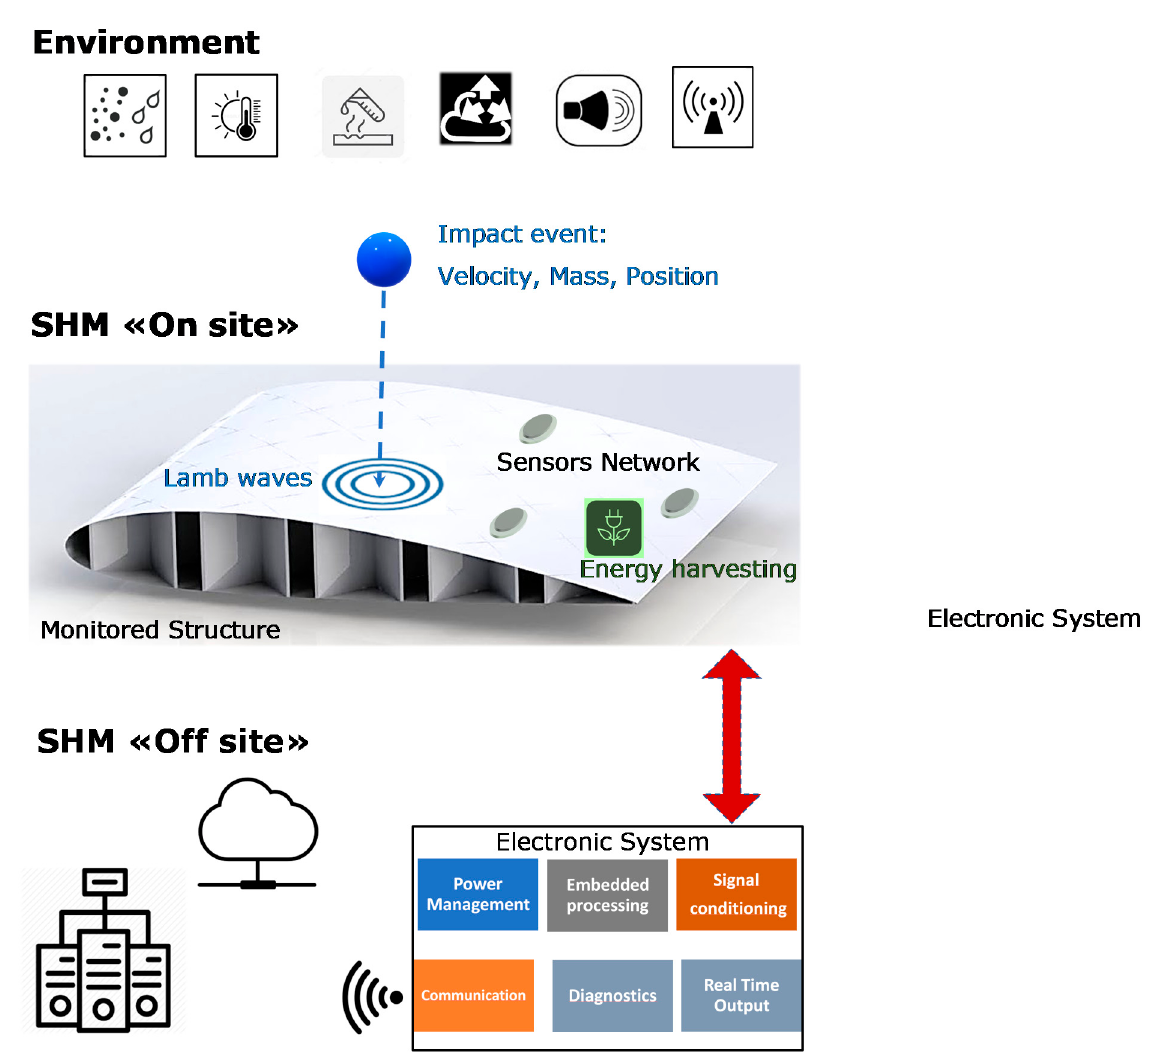
Figure 1. Graphical representation of an advanced structural health monitoring (SHM) system for impact monitoring. ( Top ) Environmental conditions (dust, moisture, temperature, pressure, vibrations, electromagnetic interference) and impact events characterized by the object mass, velocity, shape and dimensions. (Centre) On-site components of the SHM system subjected to environment conditions installed on the monitored structure (e.g., a section of a composite airplane wing). ( Bottom ) Off-site components installed remotely and connected to the sensors network; the Electronic System can operate in a protected environment (e.g., inside airplane fuselage) with real-time processing capability. Off-line signal/data processing based on big data archive with workstations connected to the web for software applications of Artificial Intelligence/Machine Learning (AI/ML) and prognostics.